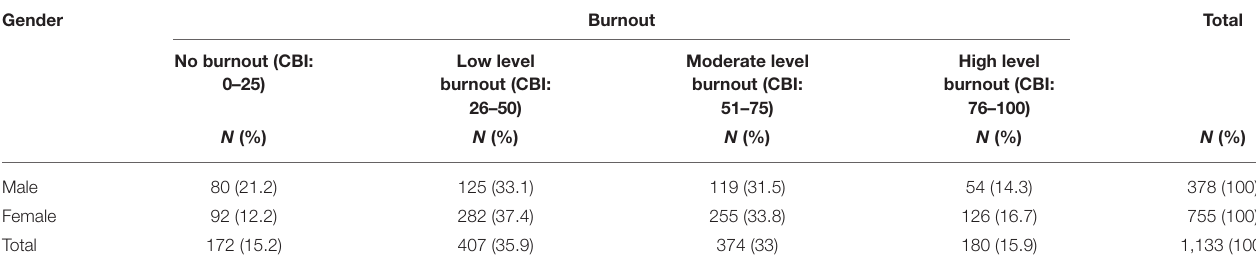
TABLE 4 | Frequency and percentage of burnout by gender ( n = 1,133).